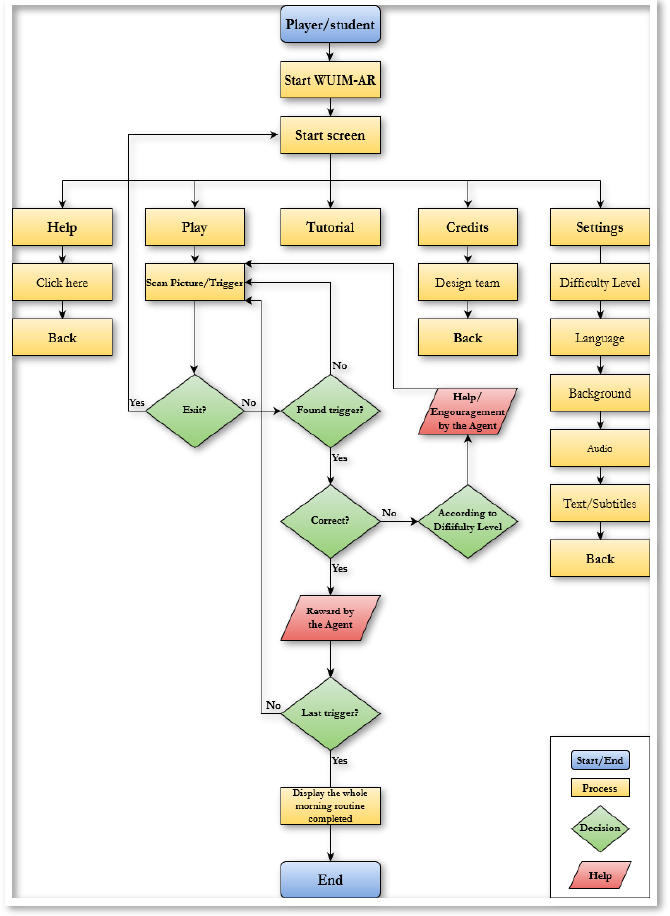
Figure 23. WUIM-AR flowchart.